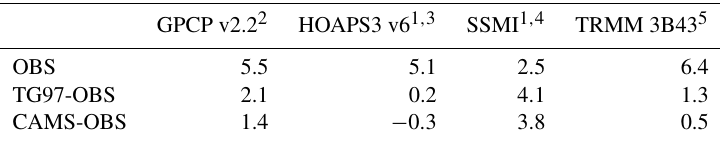
Table 3. Mean precipitation over western India (region boundaries: 25–6 ◦ N, 67–77 ◦ E) for JJA, estimated by different products and model bias for two forecast experiments for the period 2001 to 2004. Data are in millimetres per day.